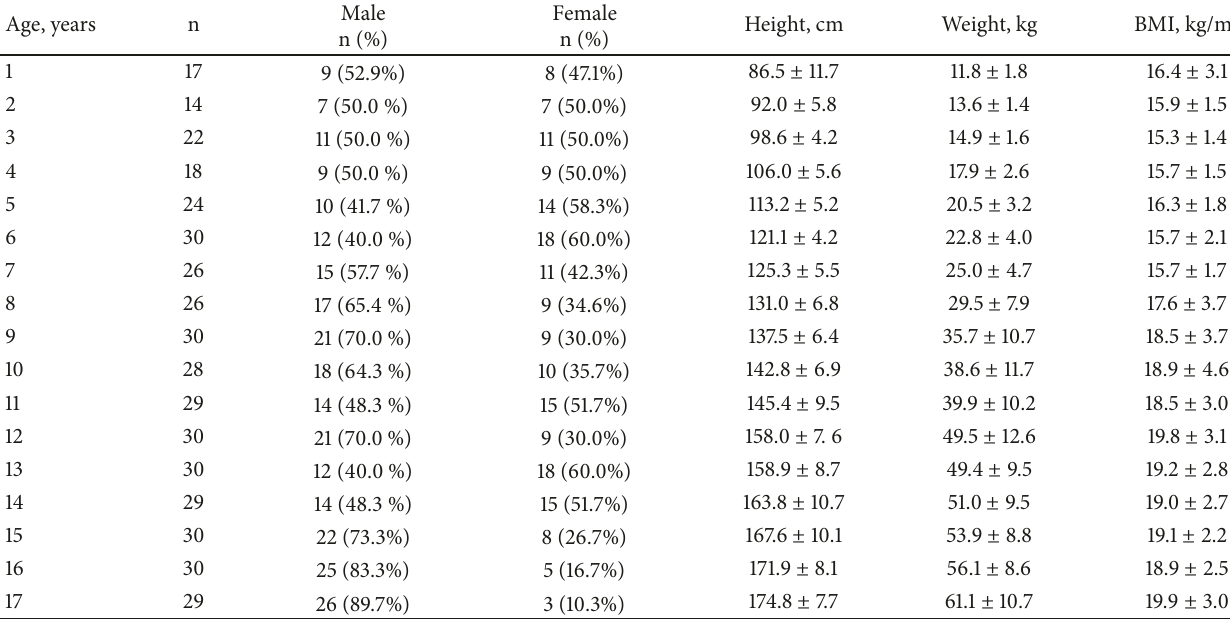
Table 1: The distribution of number of subjects, male to female ratio, height, weight and BMI by age group among patients aged 1–18 years. Age, years n